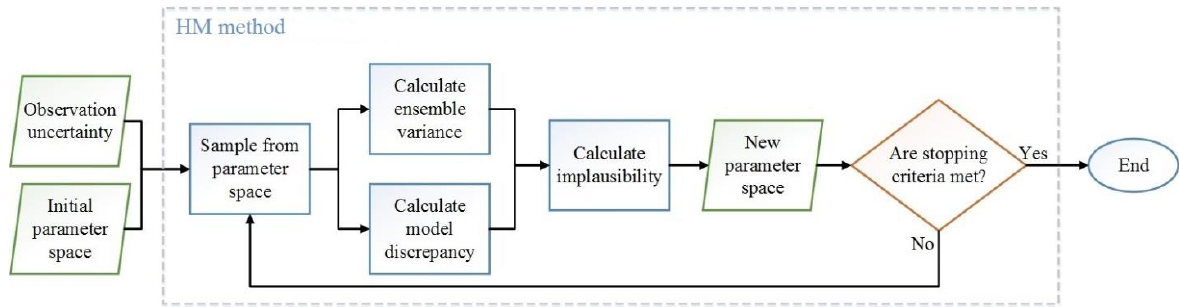
Figure 5. The functionality of the HM method used for model calibration.